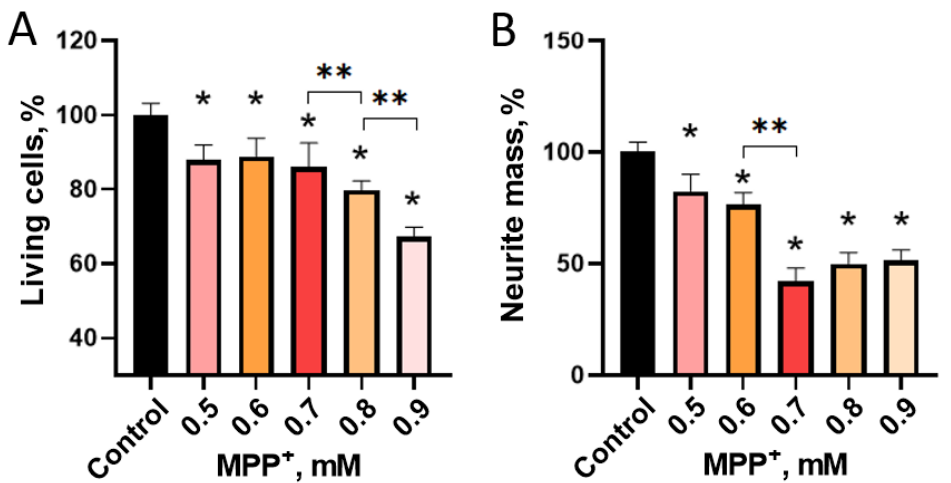
Figure 8. The number of LUHMES cells ( A ) and the mass of neurites ( B ) after their incubation in a differentiation medium with 1-methyl-4-phenylpyridinium iodide (MPP + ) at a gradually increasing concentration compared to the control (incubation without MPP + ). * p < 0.05, significant difference compared to the control, ** p < 0.05, significant difference between the selected groups.